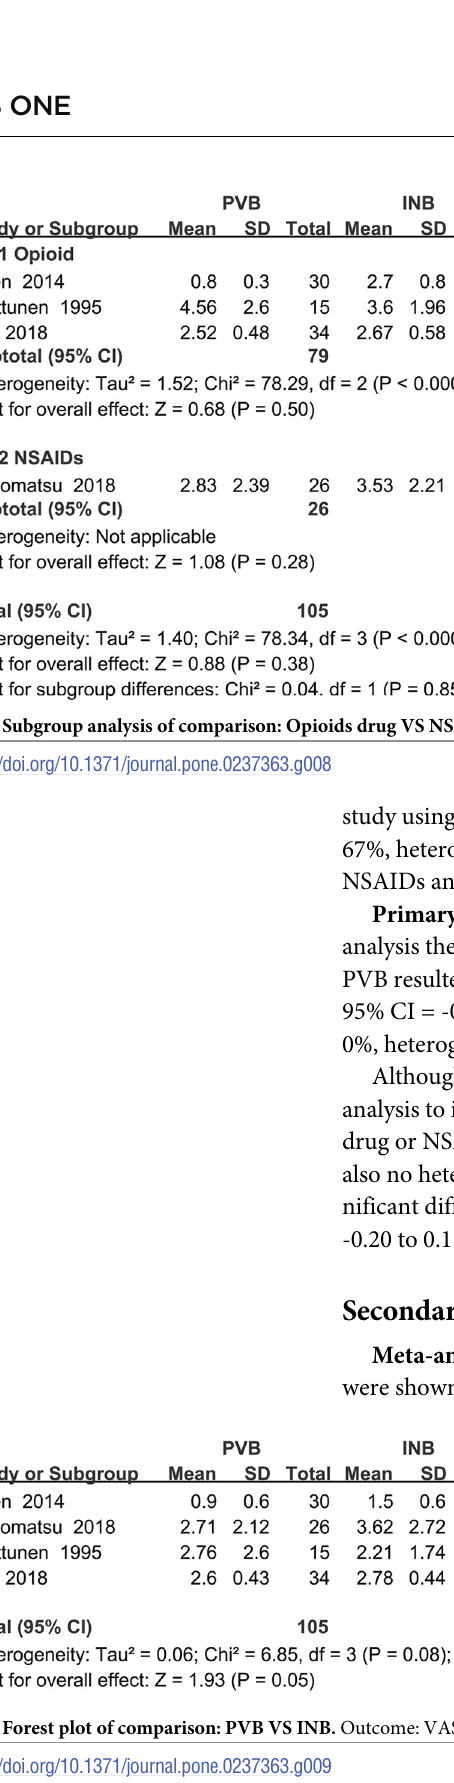
PLOS ONE | https://doi.org/10.1371/journal.pone.0237363 October 5,